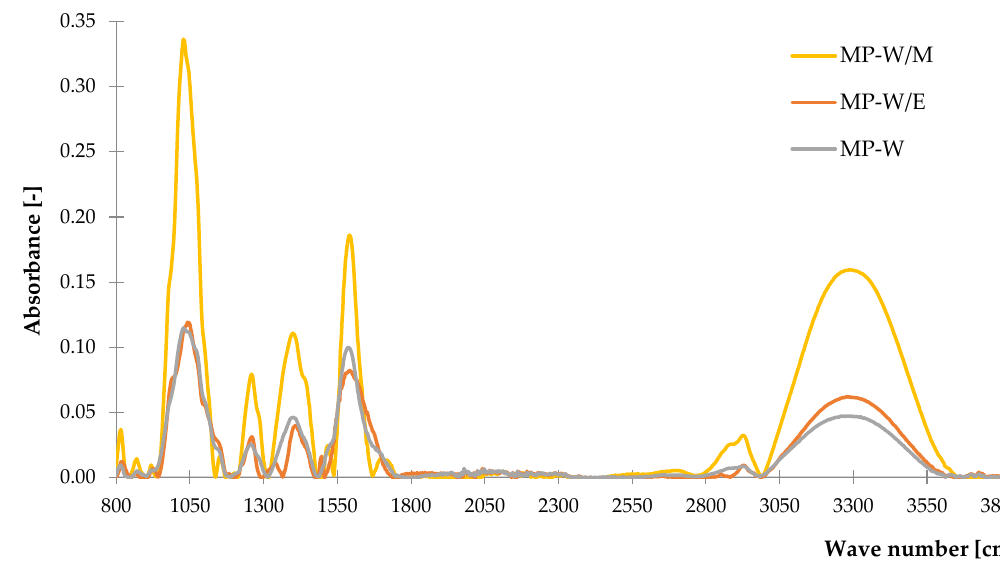
Figure 2. The FTIR spectra of peppermint freeze-dried extracts. Table 2. Characteristic functional groups registered by FTIR analysis of freeze-dried extracts. Adapted from Ref. [80].